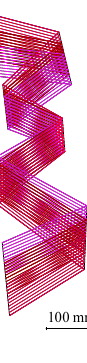
Figure 4. Planar system P 0 .